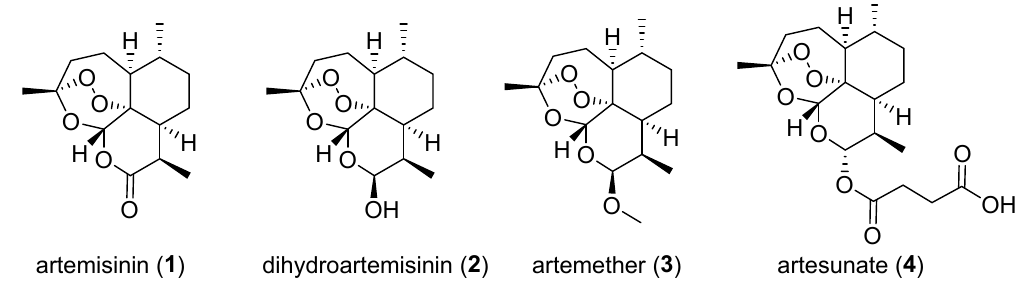
Figure 1. Artemisinin and its semi-synthetic derivatives.